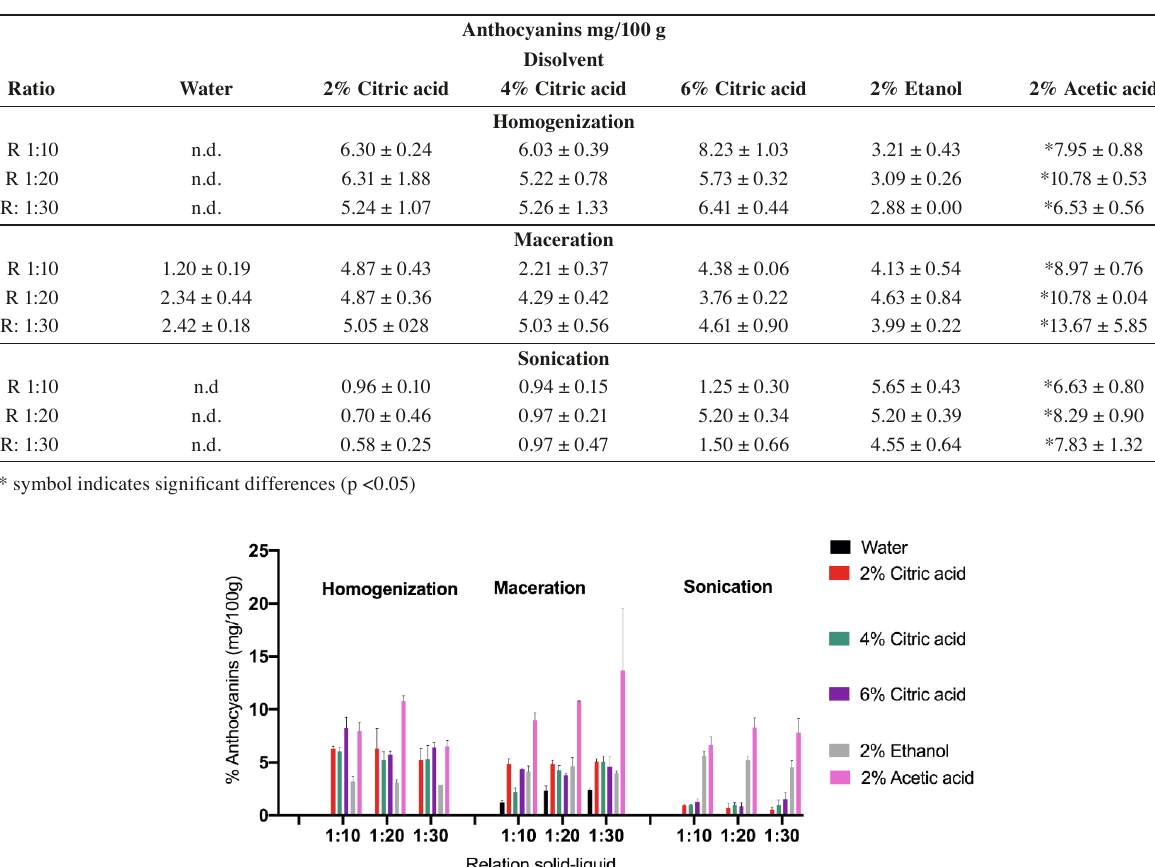
Tab. 1: Anthocyanin yields in fresh dahlia petal extracts